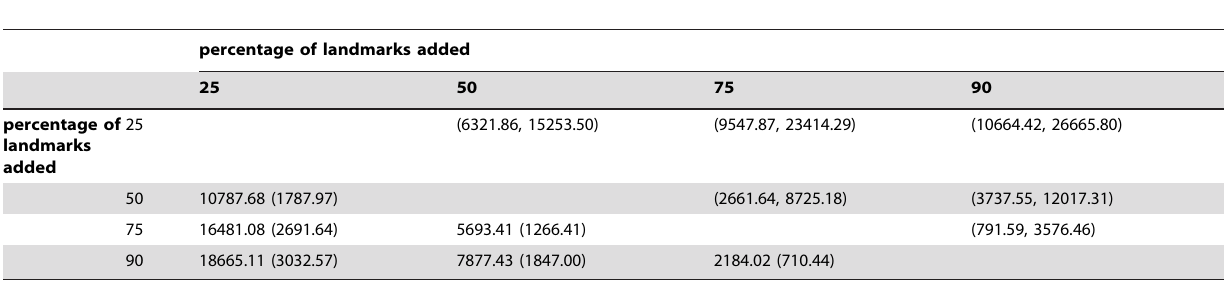
Table 4. Post hoc pair-wise comparisons of the GEE for volume variances and percentage of landmarks.